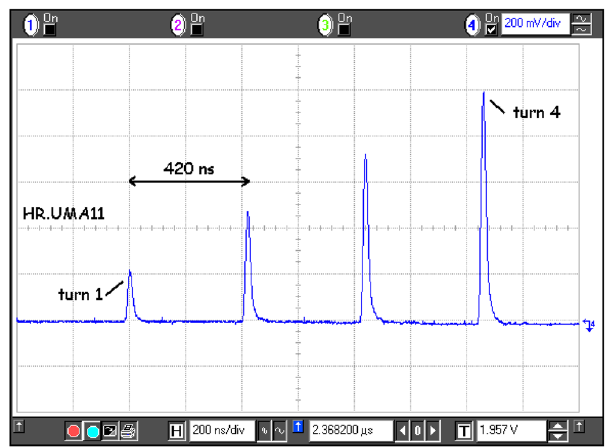
FIG. 19. (Color) Intensity signal of a beam position monitor in the ring for a bunch combination with a factor